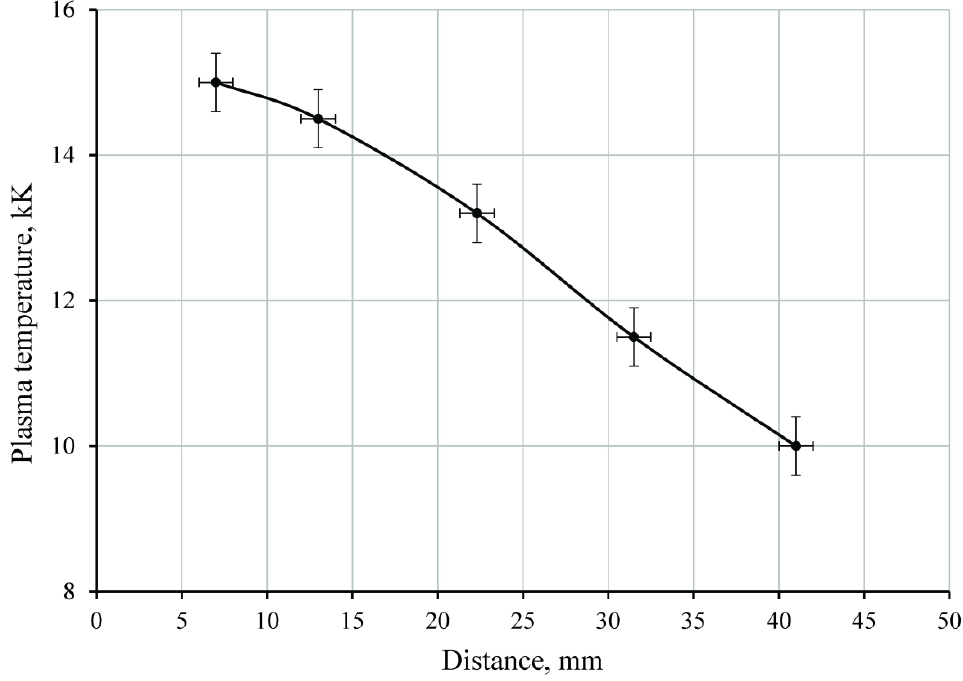
Figure 9 . Distributions of the maximum plasma temperature along the sample length (for point F) .